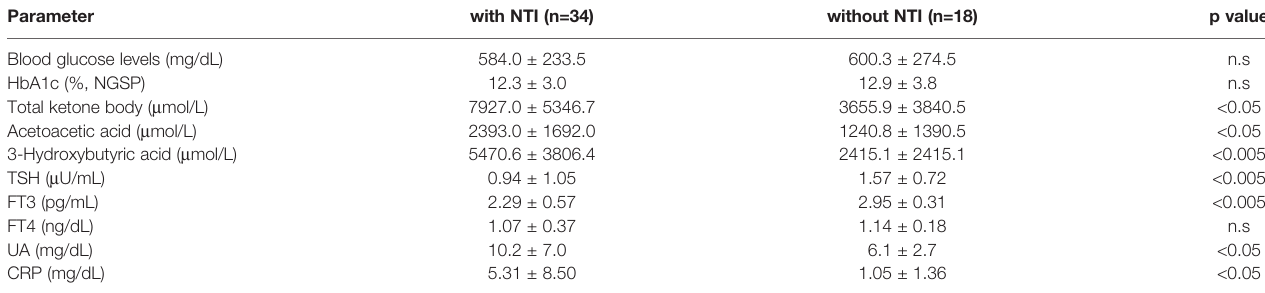
TABLE 2 | Comparison of various parameters in subjects with and without NTI.